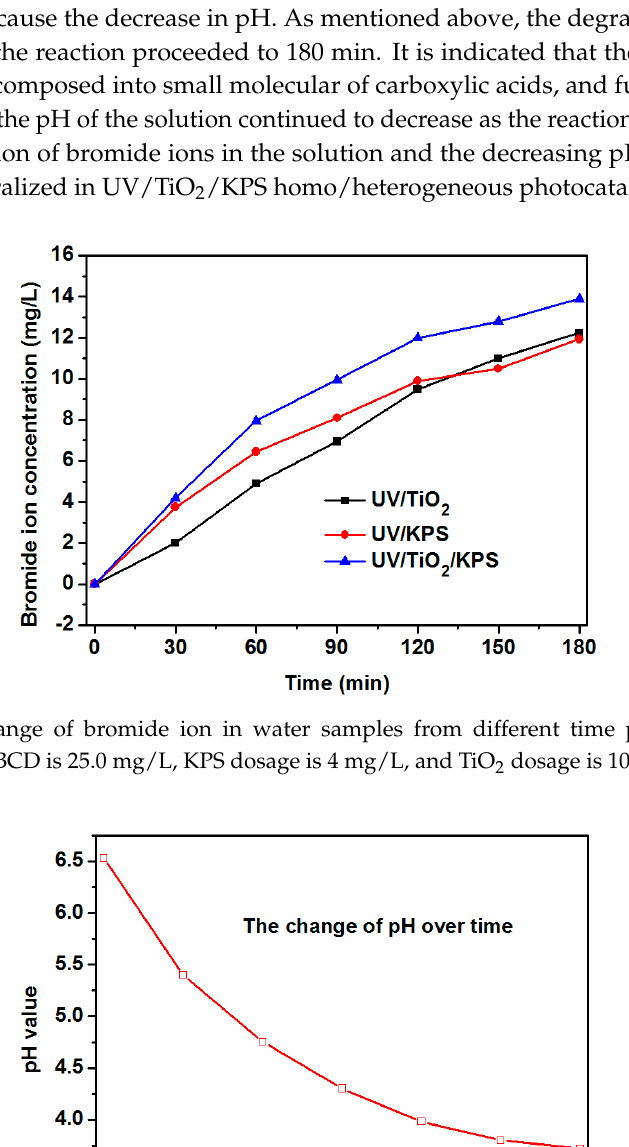
Figure 5. The change of pH over time (the initial concentration of HBCD is 25.0 mg/L, KPS dosage is 4 mg/L, and TiO 2 dosage is 100